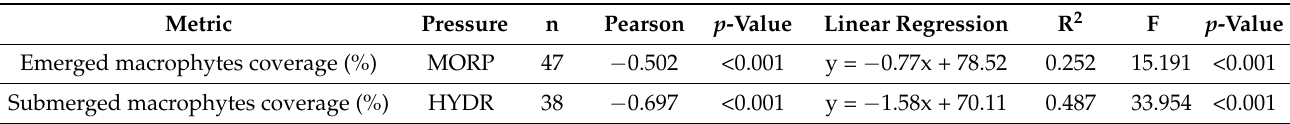
Figure 7. Relationship between specific pollutants pressure level with ( a ) dissolved oxygen concentration, and ( b ) benthic invertebrate index, as EQR. Spearman coefficient (with Table 2 and significance of the regression model) are shown. Table 5. Correlations and linear regressions of the macrophytes metrics with the hydro-morphological pressure levels (HYDR: hydrological pressures, MORP: morphological pressures).